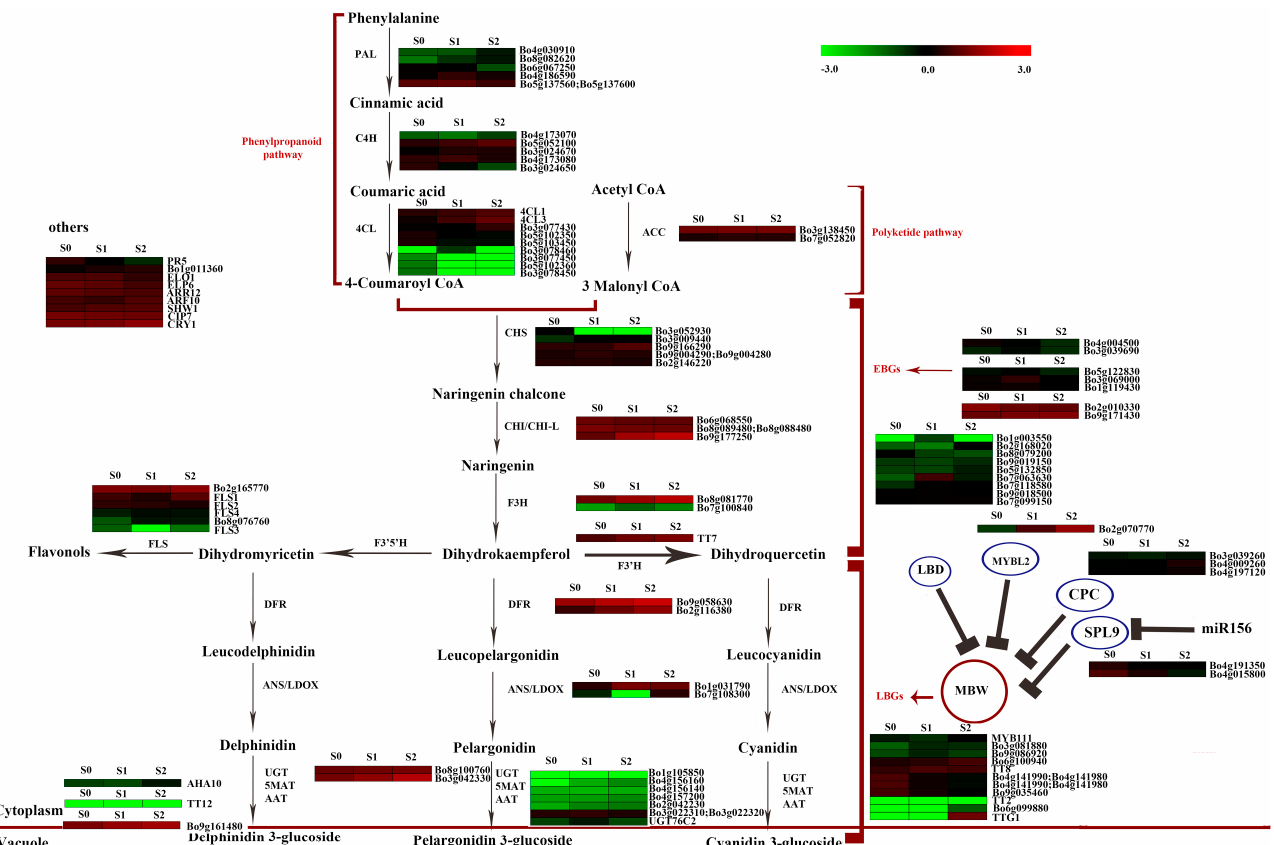
Figure 7. The expression levels of the genes involved in anthocyanin biosynthesis at each stage of leaf development (S0, S1, and S2). PAL: phenylalanine ammonia-lyase; C4H: cinnamic acid